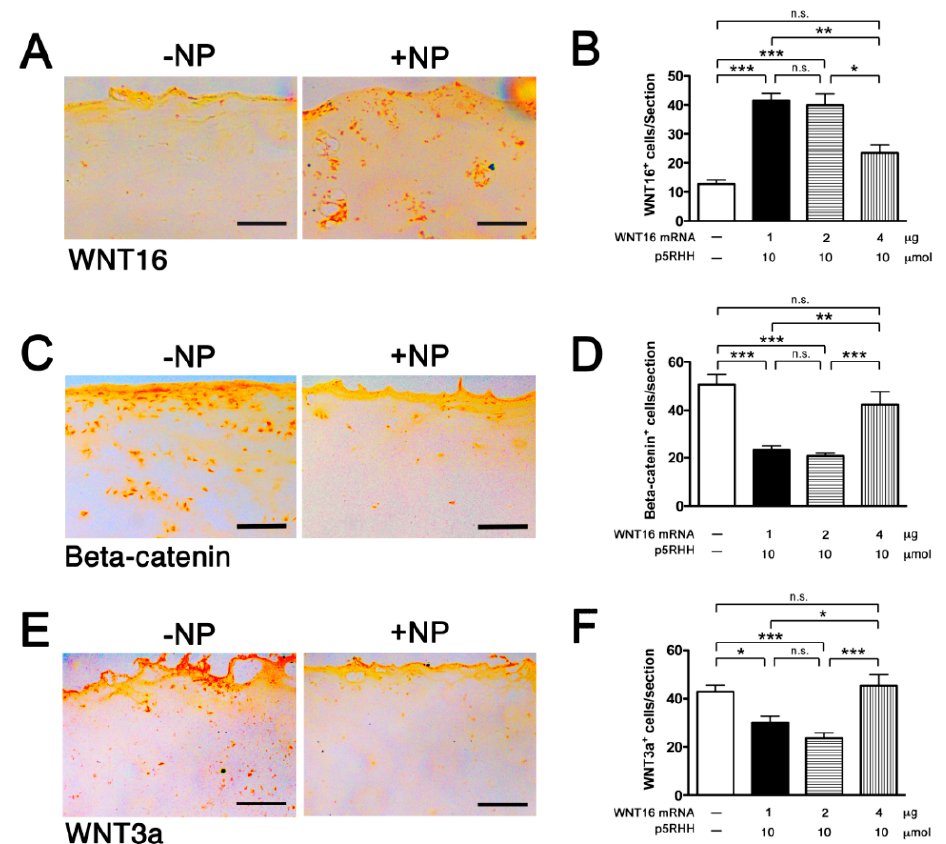
Figure 5. HA-coated p5RHH-WNT16 mRNA NPs generated at the indicated concentrations of mRNA and p5RHH were incubated with 5 mm 2 cartilage discs derived from human OA knee joints. After 48 h, cartilage explants were washed, processed, and examined for WNT16 ( A , B ), Beta-catenin ( C , D ), and WNT3a ( E , F ) expression. Immunohistochemistry (IHC) photomicrographs were derived from cartilage discs transfected with 1 µg of peptide-mRNA NPs. Scale bar = 100 µm. The numbers of WNT16+, beta-catenin+, and WNT3a+ cells/cartilage section were enumerated. Values represent mean ± SEM. Data were derived from 6 to 8 cartilage sections, from 4–6 independent human cartilage explants. * p < 0.05, ** p < 0.01, *** p < 0.001, n.s. = not significant.